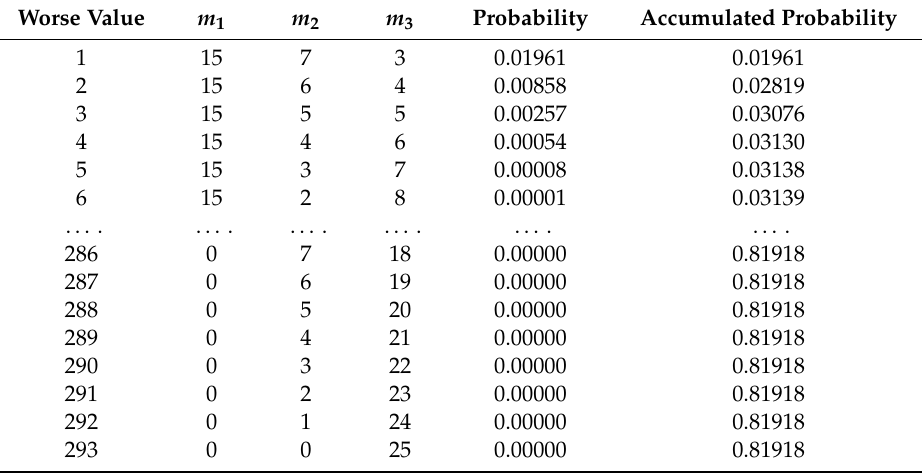
Table A1. Worse values for the calculation of the exact significance of the